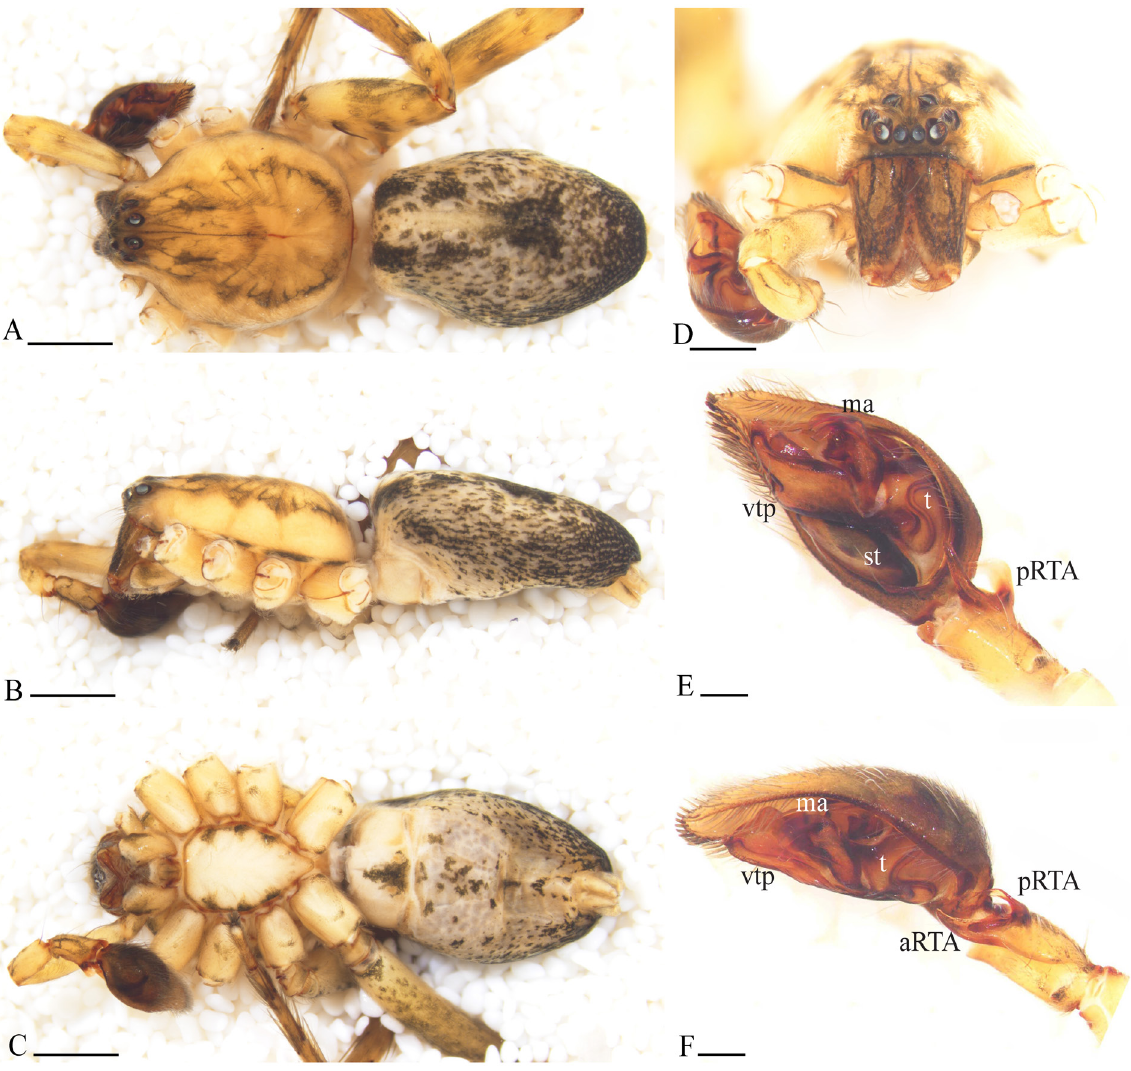
Fig. 50. Anyphaena stigma sp. nov., paratype, ♂ (CNAN-T01574). A . Dorsal habitus. B . Lateral habitus. C . Ventral habitus. D . Prosoma, anterior view. E . Pedipalp, ventral view. F . Pedipalp, retrolateral view. Scale bars: A–C = 1.0 mm; D = 0.5 mm; E–F = 0.2